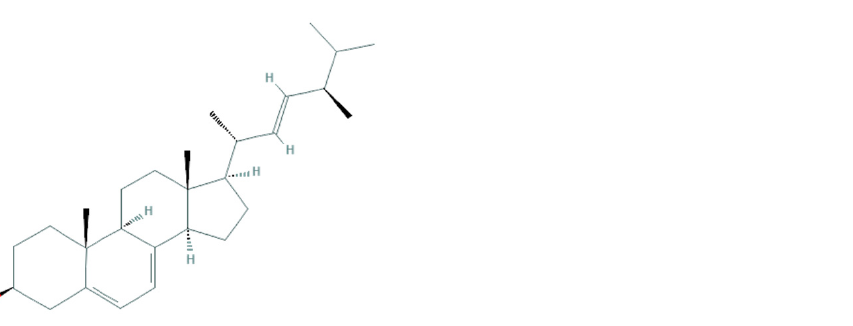
Figure 2. Ergosterol (C 28 H 44 O). Chemical structure obtained from PubChem database 4 August 2021 (https://pubchem.ncbi.nlm.nih.gov/compound/444679#section=2D-structure).